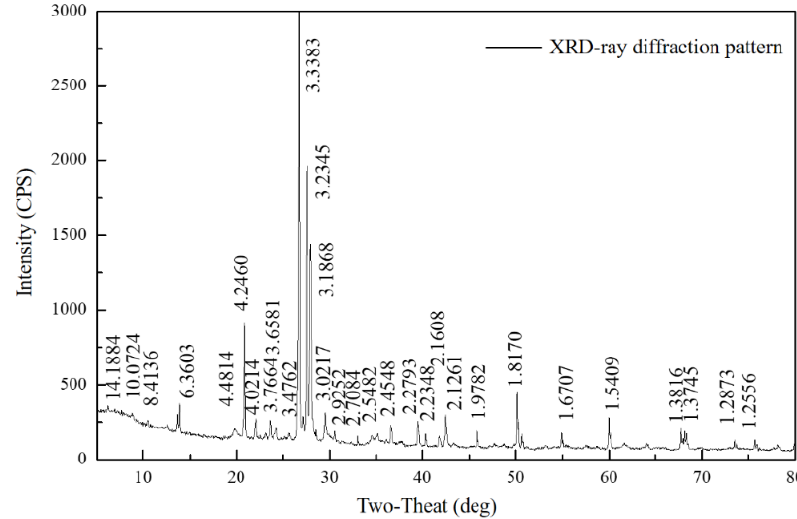
Figure 1. Natural soil specimens were obtained from sampling sites. Notes: ( a ) Saline soil site; ( b ) Surrounding environment; ( c ) Nature soil specimen.